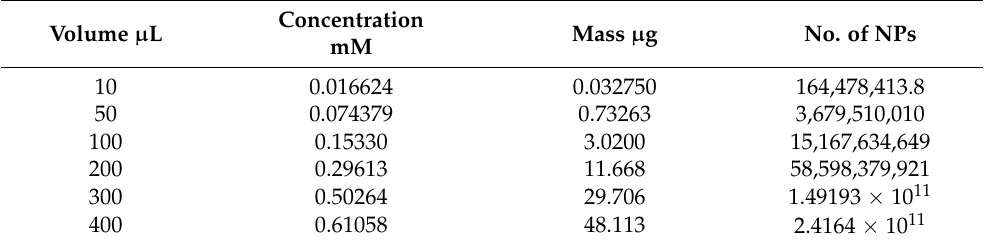
Table 2. Synthesized AuNPs by different reducing